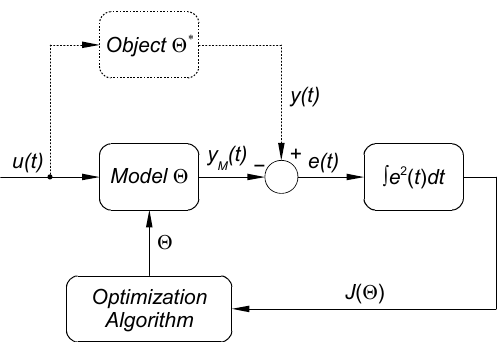
Figure 11. A diagram of the process of object identification. u ( t )—input signal; y ( t )—object response; y M ( t )—response of the object model; e ( t ) = y ( t ) − y M ( t )—identification error; J ( Θ ) = —quality indicator of compatibility of model and object; Θ i Θ *—respectively, model and real object parame- ters.